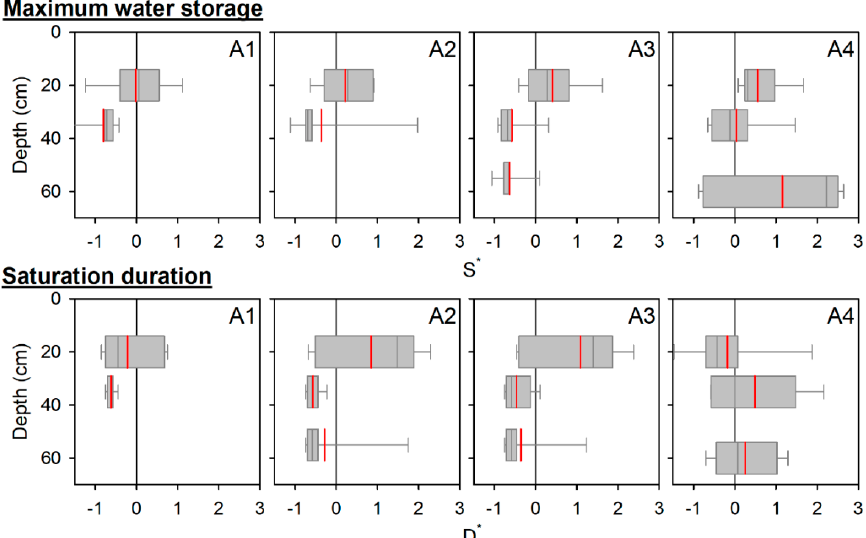
Figure 8. Variation in rescaled water storage (S*) and rescaled saturation duration (D*) at each point on measurement lines A1–A4 during effective rainfall events. Boundaries of the box indicate the 25th and 75th percentiles, the grey line within the box shows the median value, the red line indicates the mean value, and error bars represent the 10th and 90th percentiles.